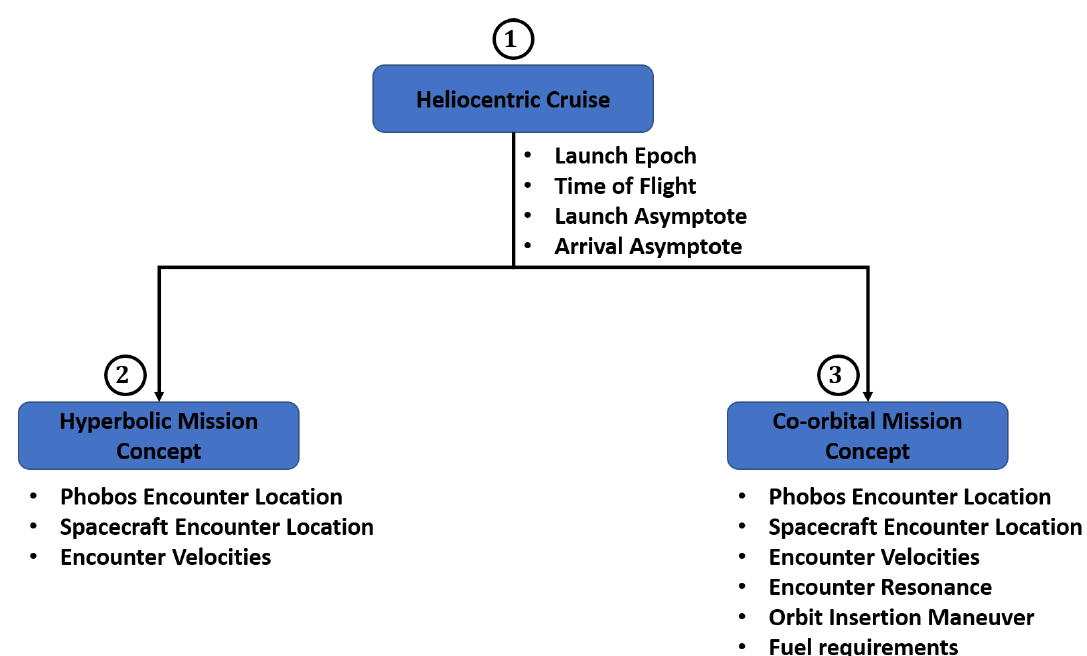
Figure 5. The layered tree architecture used in the current work to design the Perseus mission concept